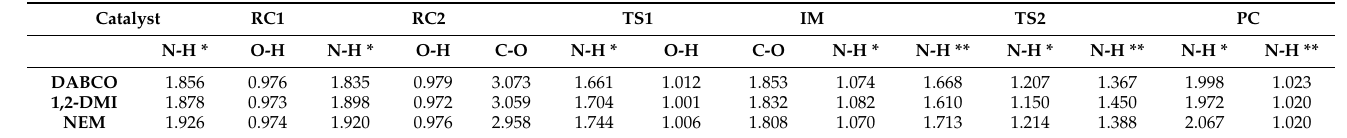
Table 4. N-H, O-H, and C-O bond lengths (Å) along the phenyl isocyanate (PhNCO) and butan-1-ol reaction pathway in the presence of the studied catalysts: 1,4-diazabicyclo[2.2.2]octane (DABCO), 1,2-dimethylimidazole (1,2-DMI), and N-ethylmorpholine (NEM). N-H * for catalysts, while N-H ** for